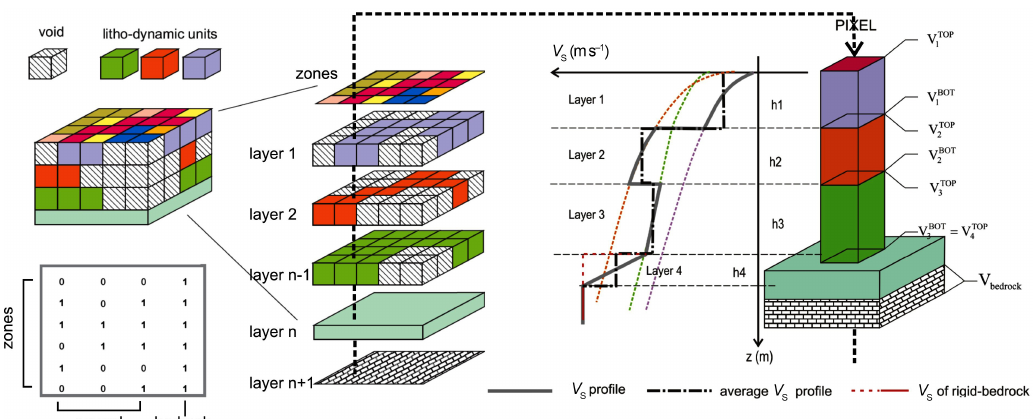
Figure 2. Subsoil half-space modelling by the GIS cubic model (GCM) and binary template matrix (e.g. referred to four layers, three covered layers, and one non-rigid bedrock) and 1-D layered V S – h profile deriving from the GCM computational analysis (figure from Grelle et al., 2014).